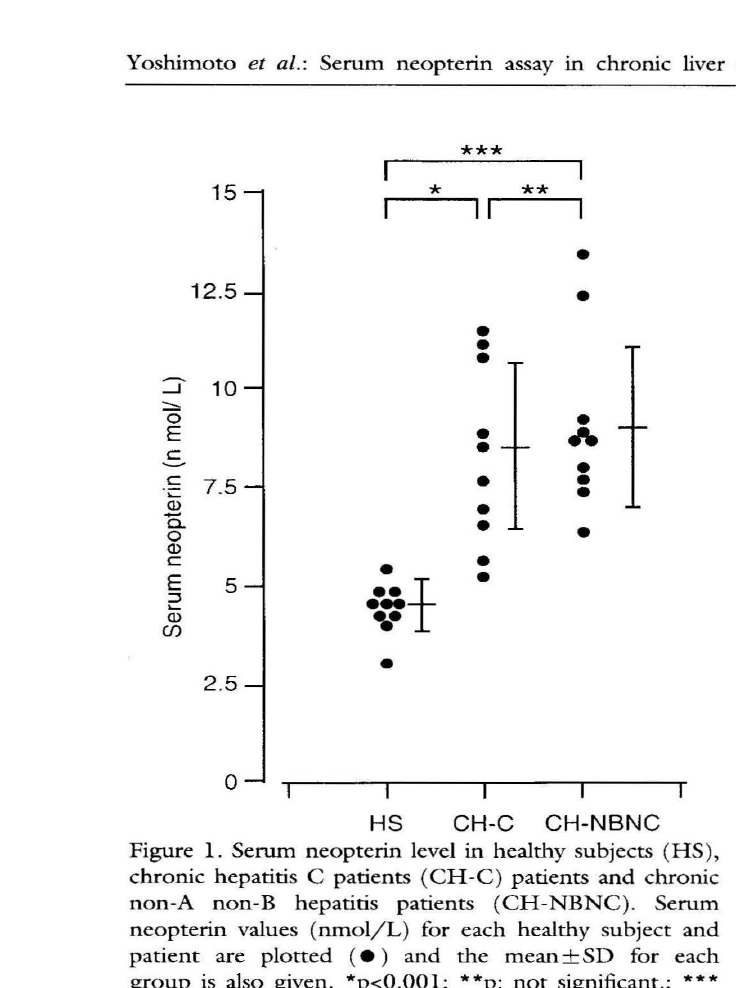
Figure 1. Serum neopterin level in healthy subjects (HS), chronic hepatitis C patients (CH-C) patients and chronic non-A non-B hepatitis patients (CH-NBNC). Serum neopterin values (nmoljL) for each healthy subject and patient are plotted (. ) and the mean ± SD for each group is also given. *p<O.OOI; **p: not significant.; ***